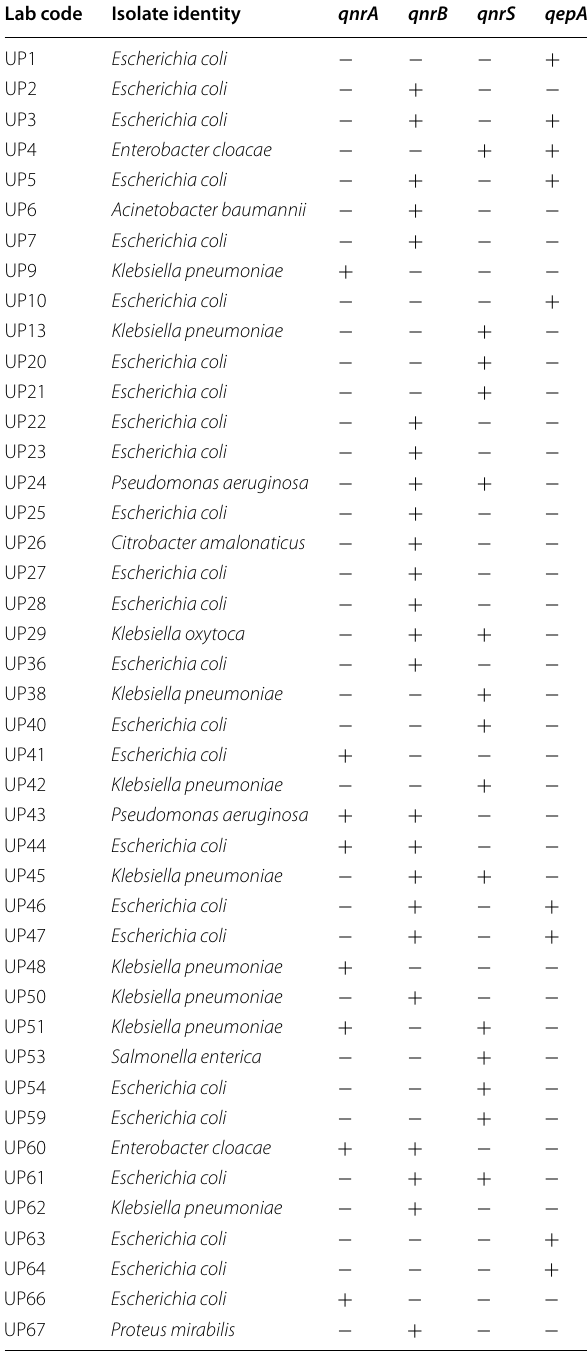
Table 3 Distribution of qnr determinants and qepA in the Urinary Tract Infection isolates showing the carriage of PMQR genes Lab code Isolate identity